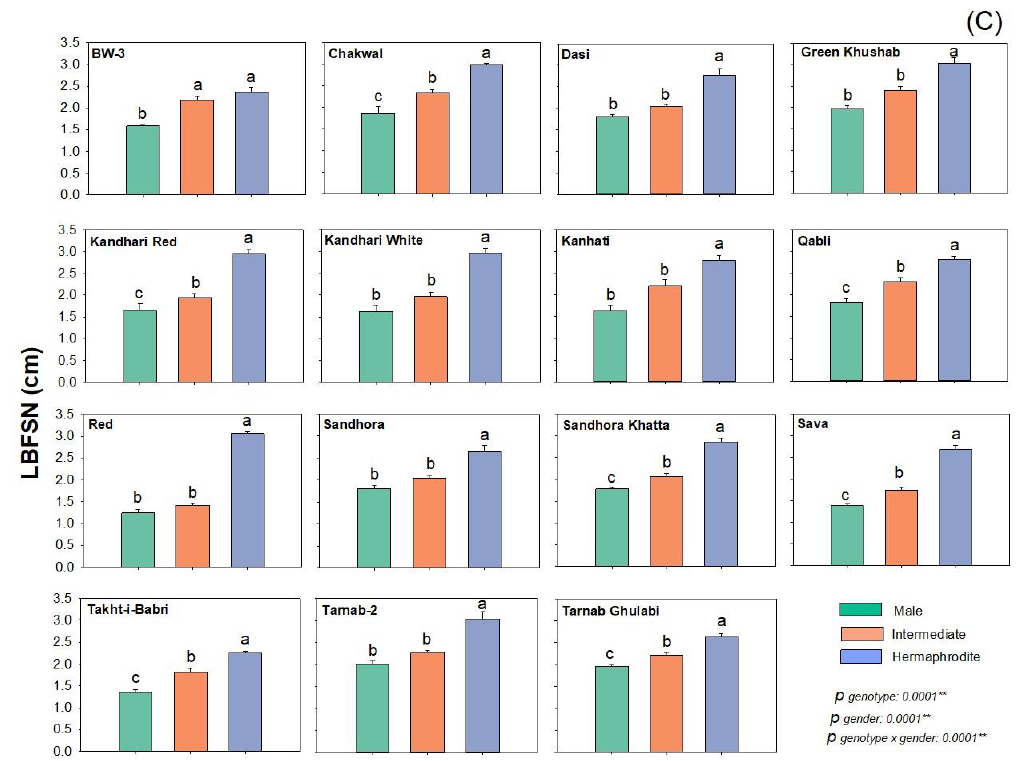
Figure 2. Difference in flower length parameters among three flower types in pomegranate genotypes ( A ) complete flower length (CFL) measured from base of the flower petal tip ( B ) length from base of the flower to tip of sepal (LBFTS) ( C ) length from base of the flower to sepal notch (LBFSN). After dissecting each flower type, the length was measured in centimeters (cm). The graph represents the mean ± S.E. of five replicates for each flower type. Different letters indicate statistical significance among flower types (Tukey’s HSD p < 0.05), ** indicates significance at p < 0.01. Table 1. Floral morphological parameters of pomegranate genotypes.